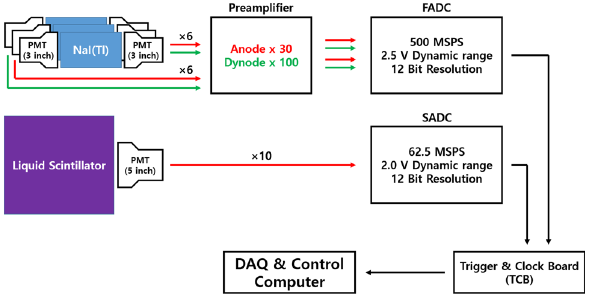
Fig. 19 Dataflowblockdiagram.Thecrystalsignalsarerecordedwith FADCs while the LS signals are recorded with SADC. Global triggers are formed at the TCB